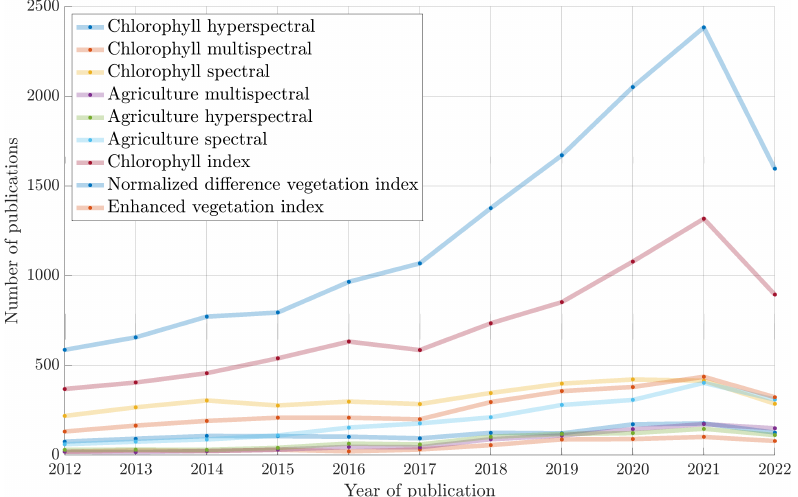
Figure 1. The popularity of topics related to the HSI analysis in various agricultural applications, including the chlorophyll estimation, quantified as the number of papers on such topics published between 2012 and 2022 (this analysis is based on https://app.dimensions.ai/discover/publication (accessed on 1 November 2022), the analysis was performed on 8 September 2022; in the legend, we present the keyphrase which was used). We can appreciate that the number of articles tackling the automated chlorophyll determination from hyperspectral imagery is increasing at a steady